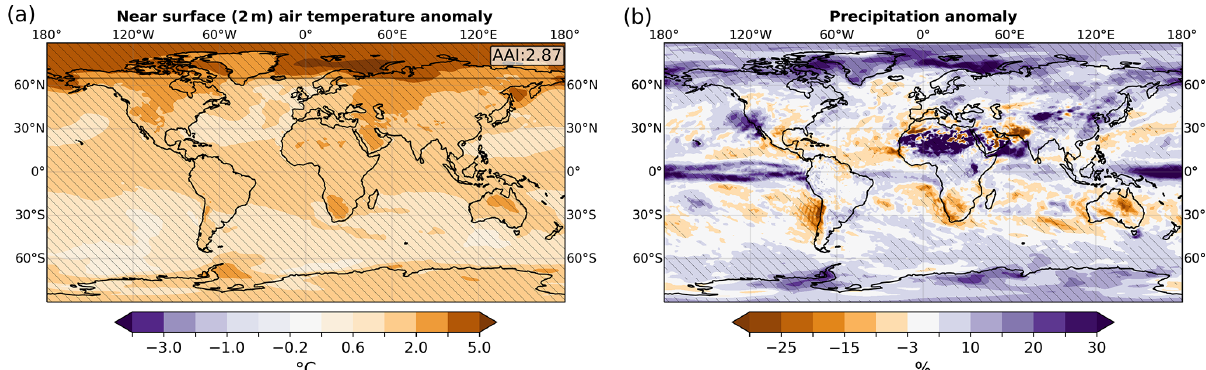
Figure 11. (a) Temperature anomaly between last 25 years of the historic simulations and the equivalent period of the pre-industrial control run. The Arctic amplification index, defined as the ratio of warming north of 65 ◦ N expressed as a fraction of global warming, is 2.87. Significant temperature anomalies are hatched, and the 95% significance is obtained via bootstrap testing. (b) Same as (a) but for relative precipitation